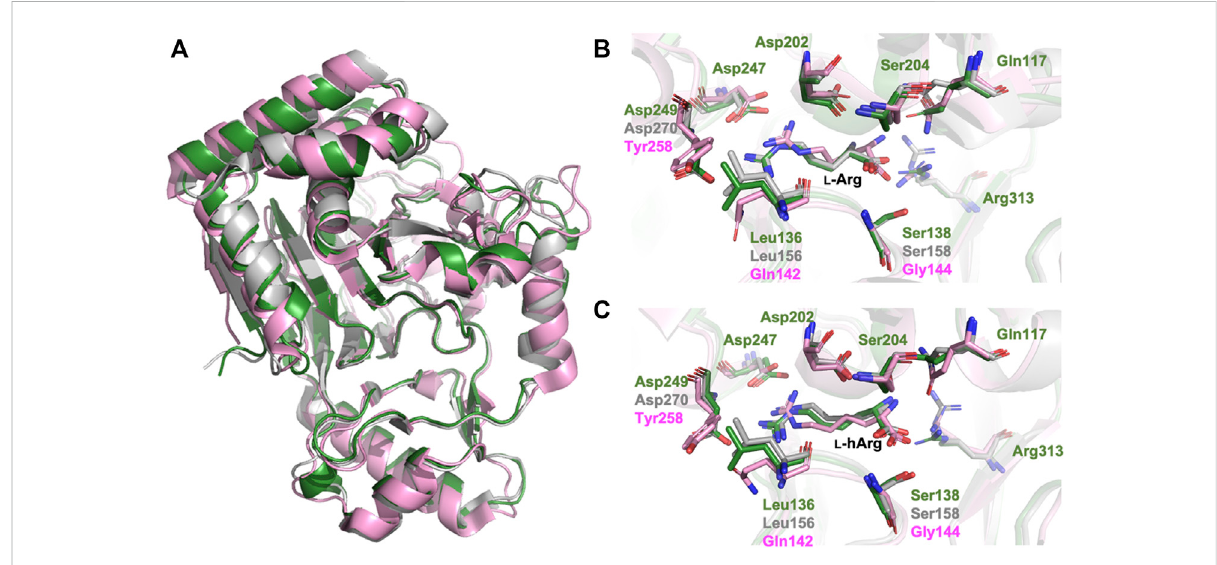
FIGURE 5 Structural comparison of CmnC, VioC, OrfP. (A) Superposition of the overall structures of CmnC, VioC, and OrfP. Local view of the (B) L -Arg binding and (C) L -hArg binding in CmnC, VioC, and OrfP. CmnC, VioC, and OrfP are colored green, grey, and pink,